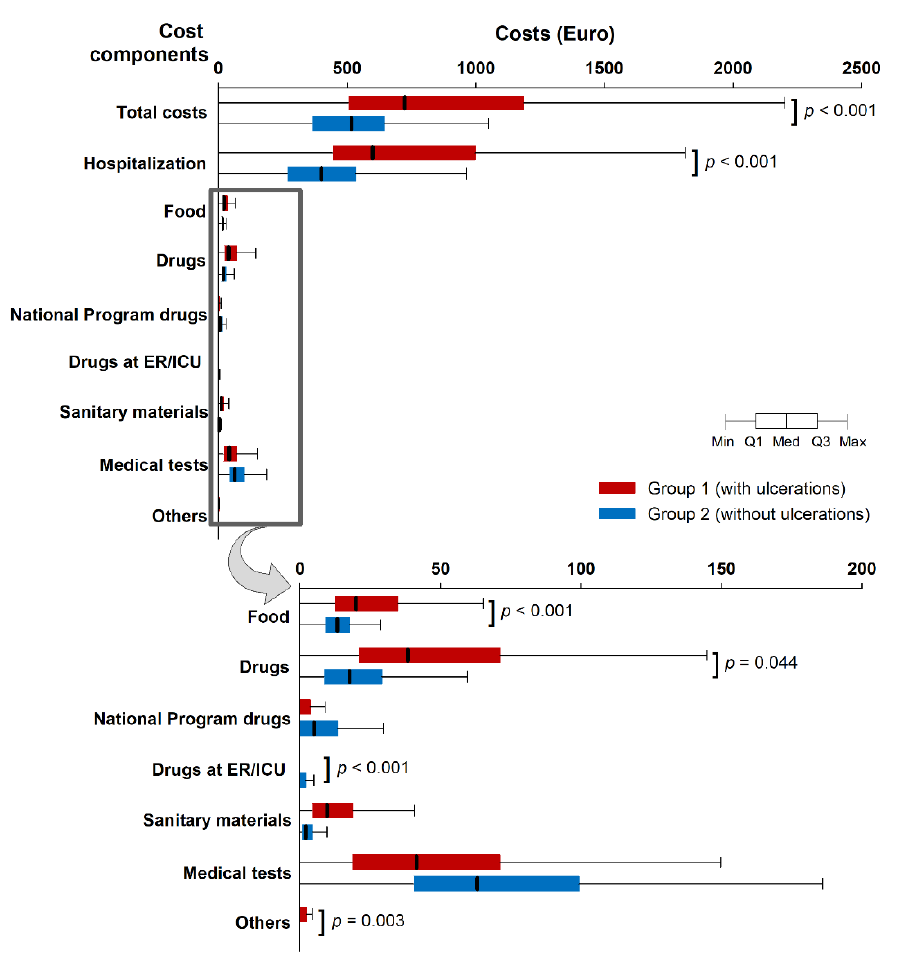
Figure 1. Comparison of hospitalization costs/patient in patients according to study group (Stu- dent-t test). Whiskers indicate non-outlier